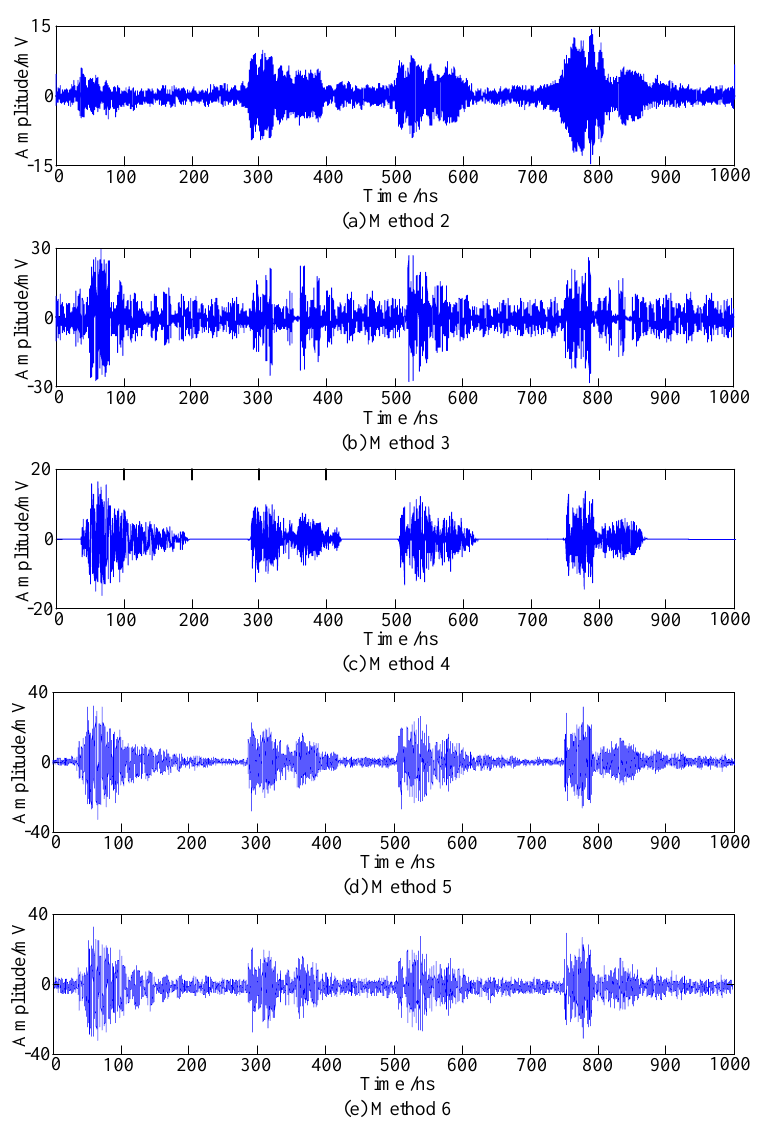
Figure 10. De-noised results using traditional de-noising methods.